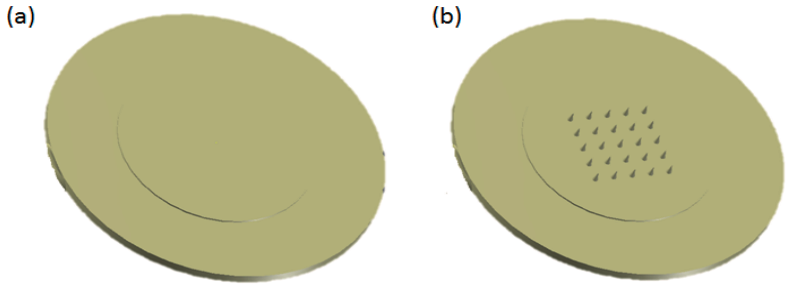
Figure 1. Micro-injection moulded samples for ( a ) flat polymer for surface analysis and ( b ) moulded MN array for dip